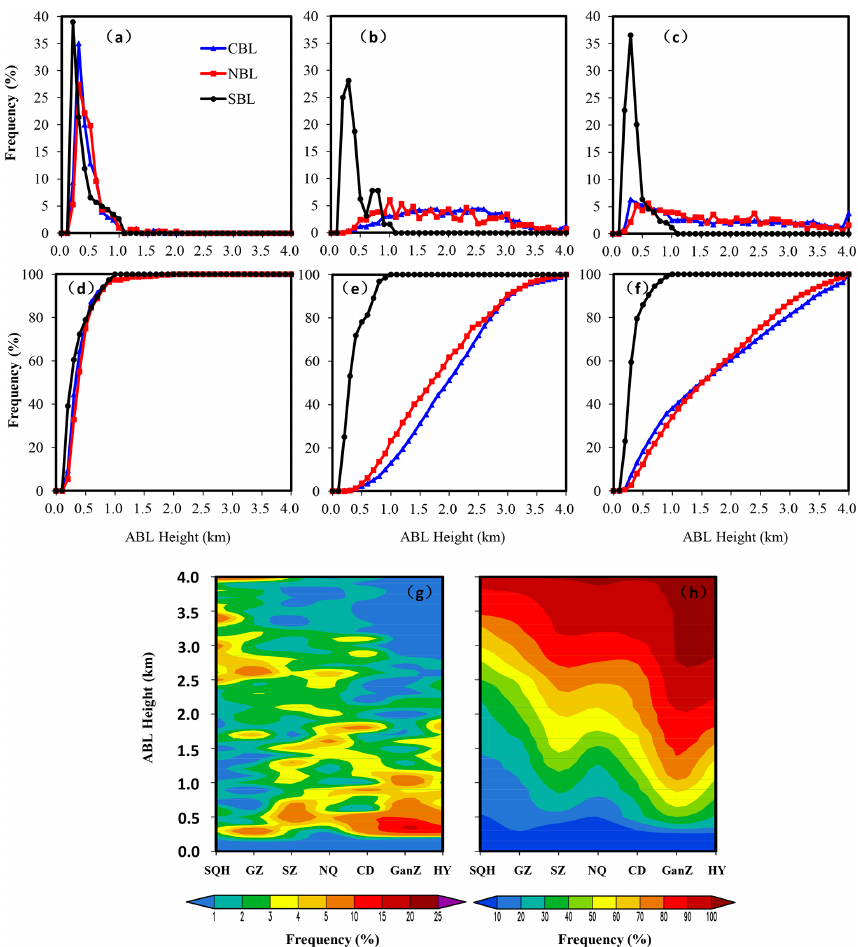
Figure 6. The regional mean frequency distributions of the ABLH over the TP for the CBL (blue), NBL (red), and SBL (black) at (a) 08:00BJT, (b) 14:00BJT, and (c) 20:00BJT; (d–f) same as in (a–c) but for the cumulative frequency distributions; the west–east cross- sections of frequency (g) and cumulative frequency (f) distributions of the CBL height along 32 ◦ N in the daytime (14:00 and